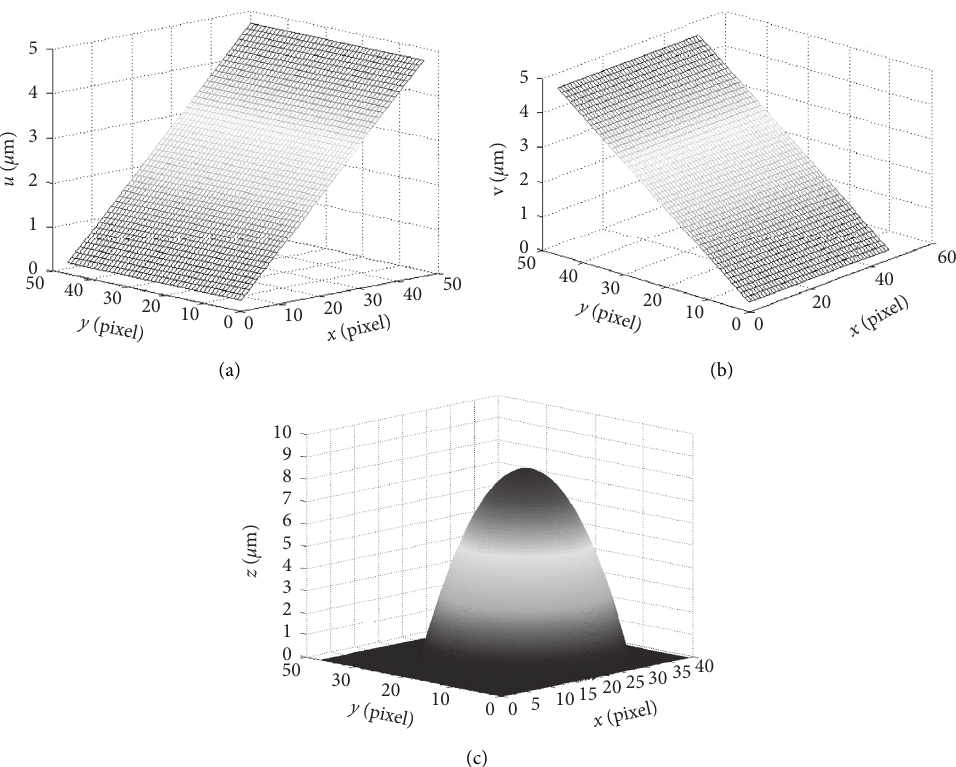
Figure 7: 3D displacement obtained using DIC. (a) u component of the in-plane displacement. (b) v component of the in-plane dis- placement. (c) Out-of-plane displacement